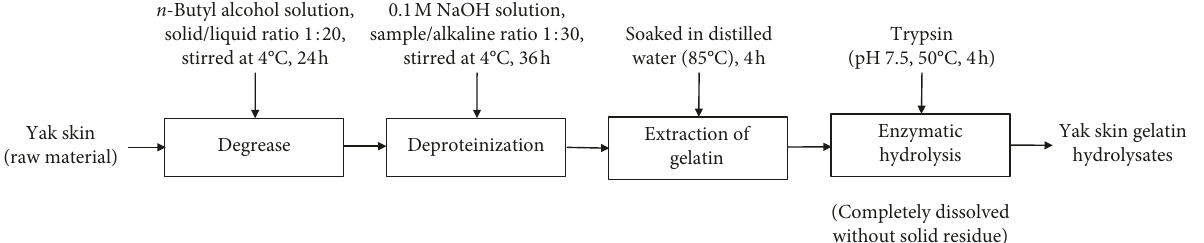
Figure 1: The technological process diagram of preparation of yak skin gelatin hydrolysates.